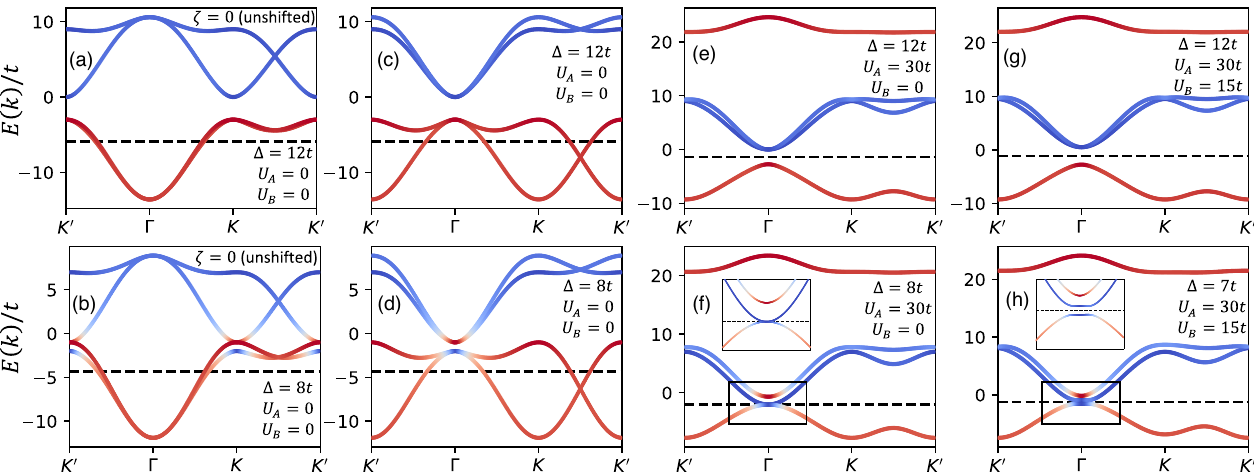
, U , before and after band inversion. A B